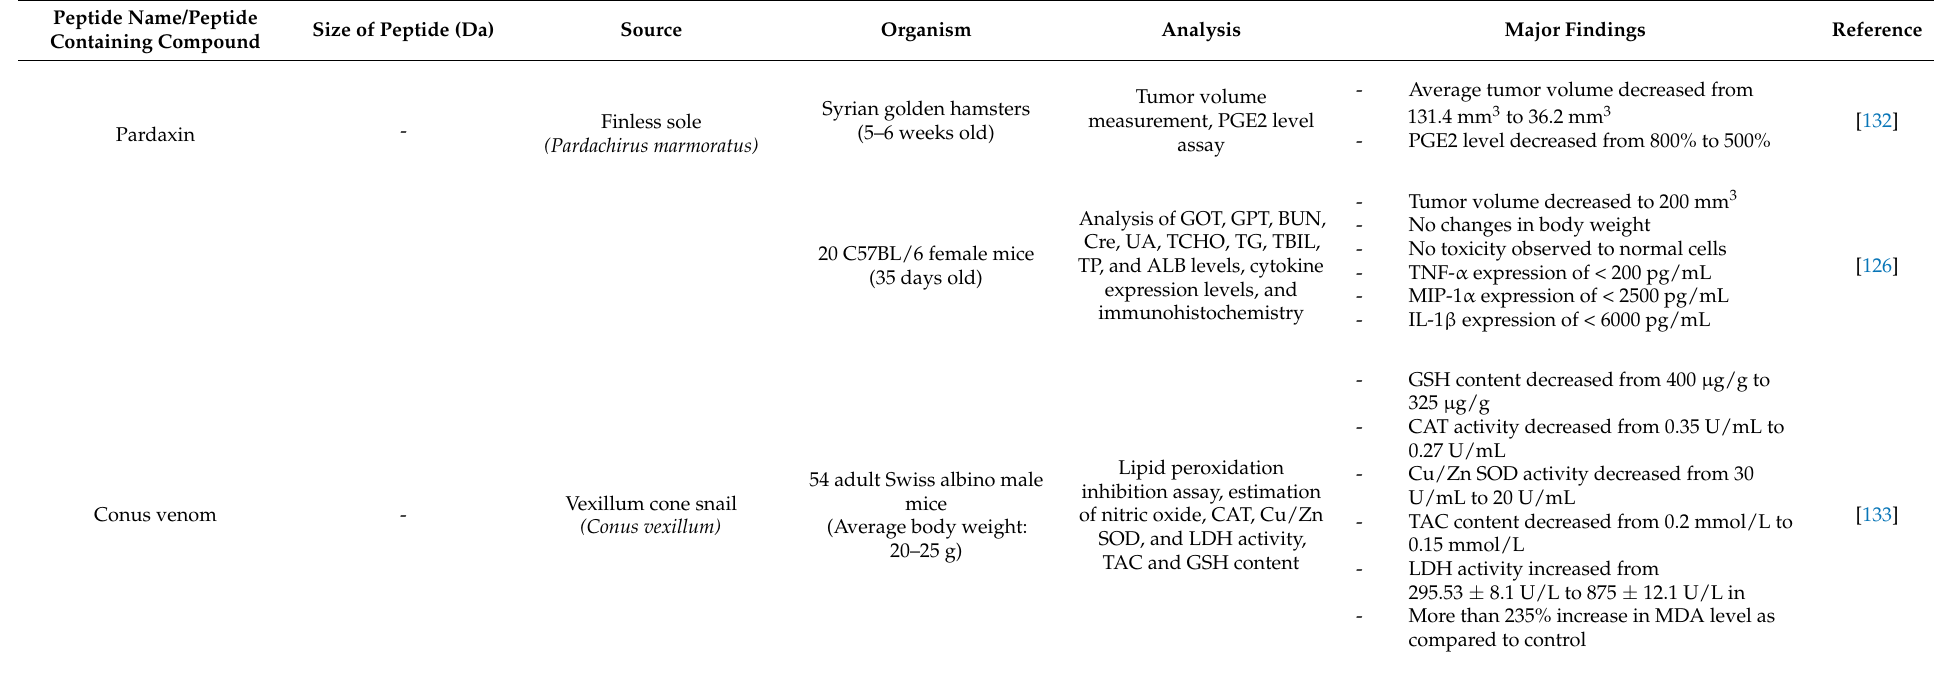
Table 5. Anticancer effects of bioactive peptides from marine animals—in vivo